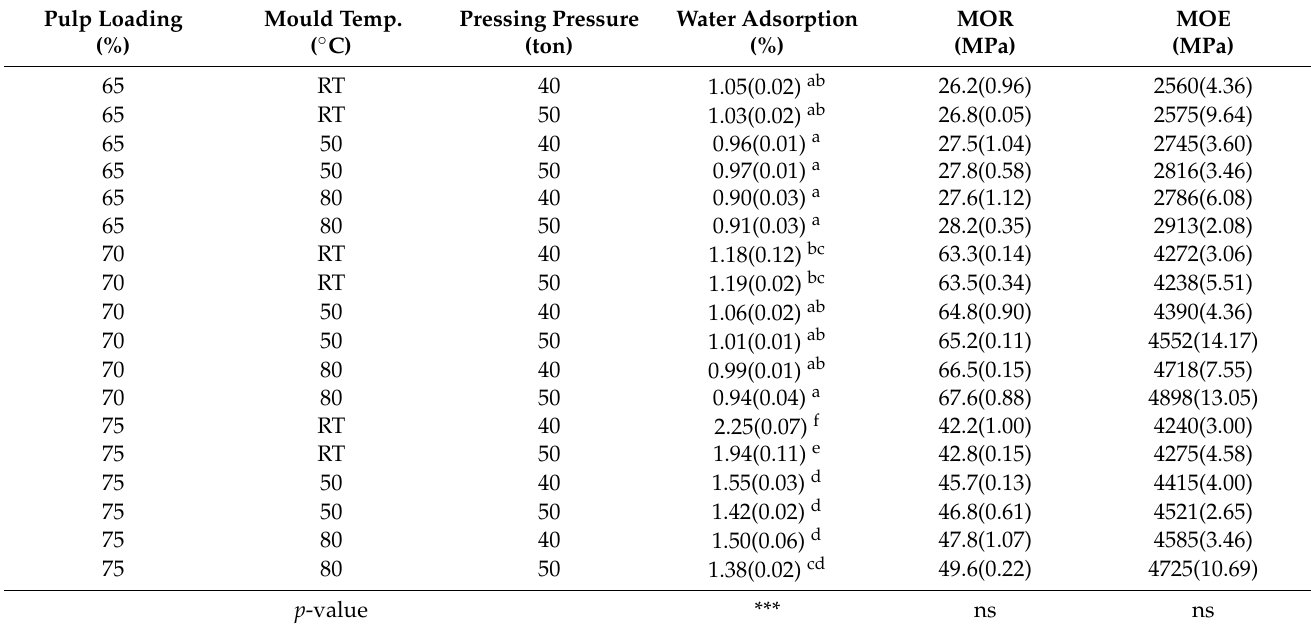
Table 8. The physical and mechanical properties of PP/OPTP composites with different injection moulding